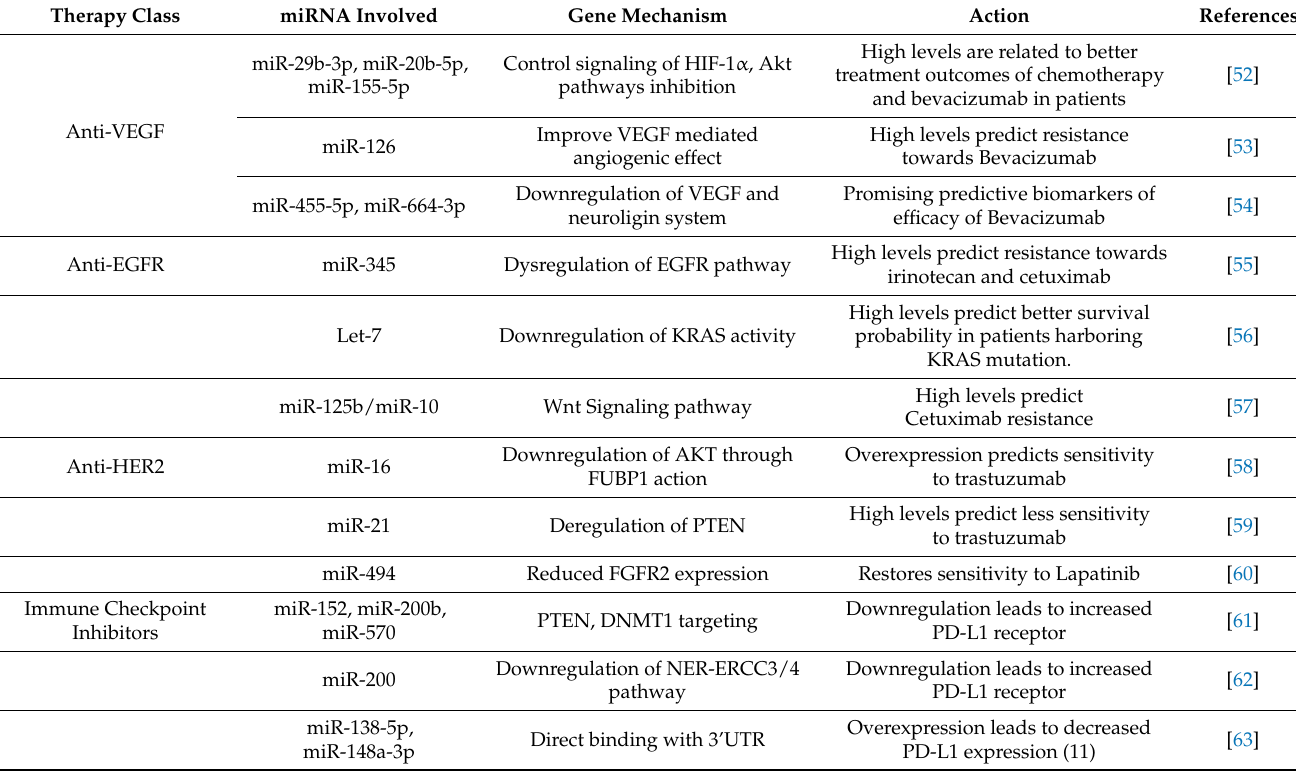
Table 3. miRNAs targeting anti-VEGF, anti-EGFR, anti-HER2, and immune checkpoint inhibitors in